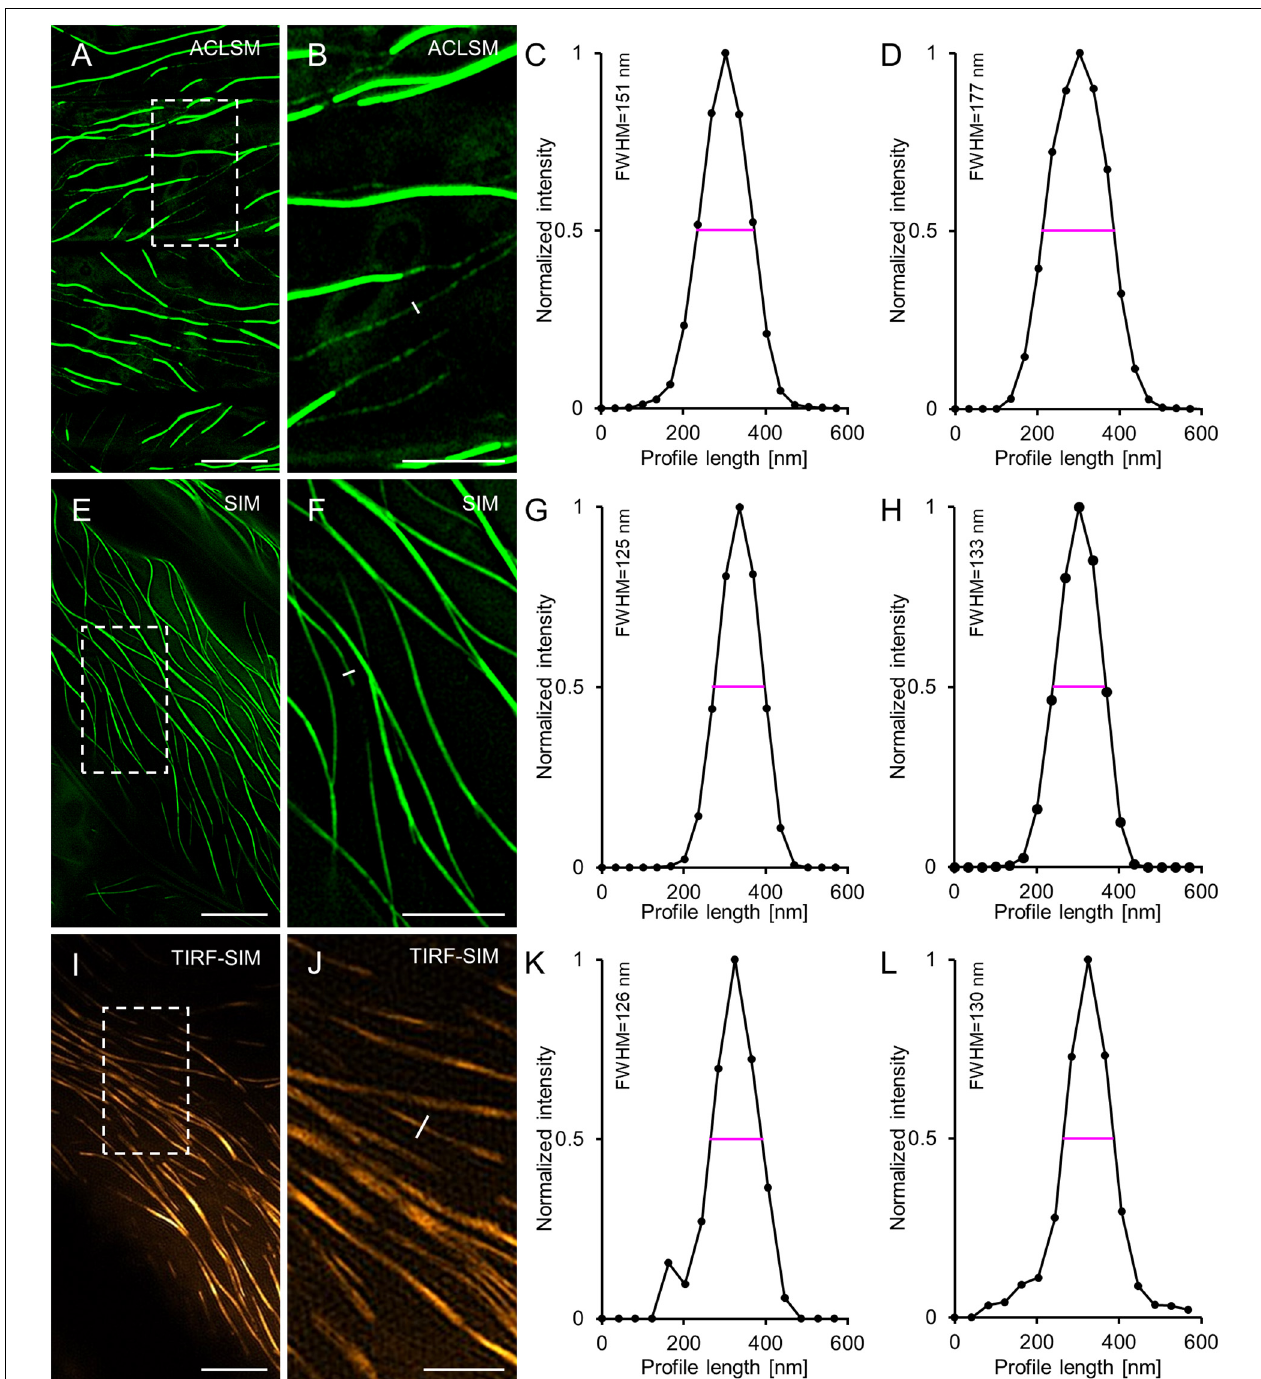
FIGURE 2 | Comparison of ACLSM, SIM and TIRF-SIM in resolving MAP65-2 decoration of cortical microtubules in hypocotyl epidermal cells of Arabidopsis expressing eGFP-MAP65-2. (A) ACLSM overview. (B) Close-up image of the boxed area of (A) with profile used for normalized intensity measurement (white line). (C) Representative quantitative depiction of normalized fluorescence intensity of the individual profile drawn in (B) . (D) Averaged, coaligned, and normalized intensity profiles of basal MAP65-2 decoration of microtubules ( N = 36; FWHM, full-width at half maximum). (E) 2D-SIM overview (objective 63 × /1.40 NA). (F) Magnified view of boxed area in (E) with the perpendicular profile, for normalized intensity measurement (white line). (G) Graph depiction of the normalized intensity corresponding to the profile drawn in (F) . (H) Averaged, coaligned, and normalized intensity profiles of basal MAP65-2 decoration of microtubules ( N = 39). (I) Overview image from TIRF-SIM (objective 100 × /1.49 NA). (J) Magnification of the boxed area of (I) . (K) Normalized intensity of the perpendicular profile drawn in (J) . (L) Averaged, coaligned, and normalized intensity profiles of basal MAP65-2 decoration of microtubules visualized with TIRF-SIM ( N = 55). Scale bars = 10 µ m (A,E) , 5 µ m (B,F,I) , and 2 µ m (J)